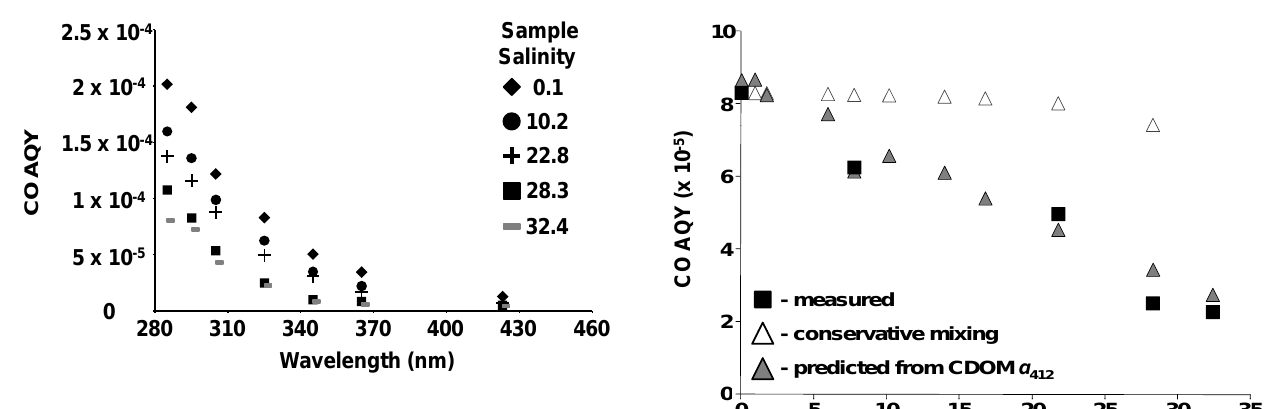
Fig. 2. Carbon monoxide apparent quantum yield spectra for the Tyne estuary.